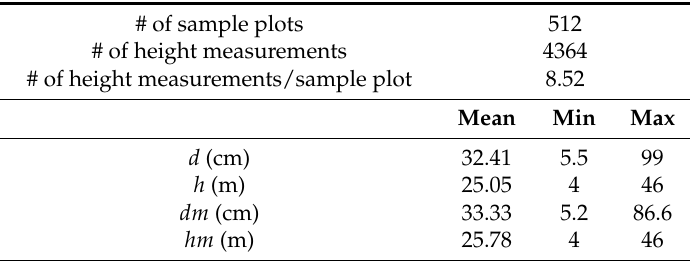
Table 3. Summary statistics of the evaluation data. d = diameter at breast height; h = height; dm = diameter of the median basal area tree per species; hm = height of the median basal area tree per species.